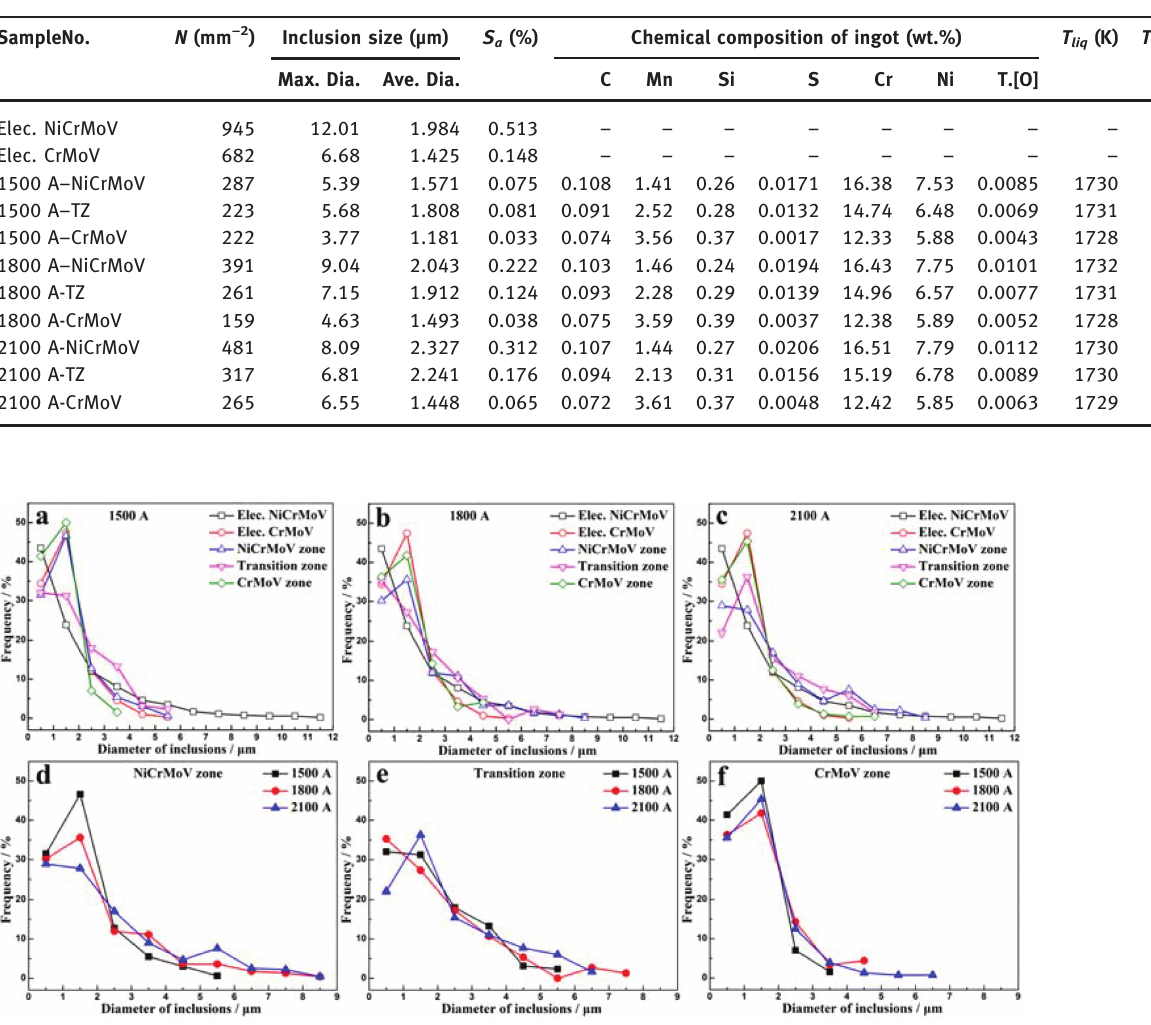
Figure 4: Size distribution of inclusions observed in consumable electrode and each dual alloy ingot processed by ESR with different